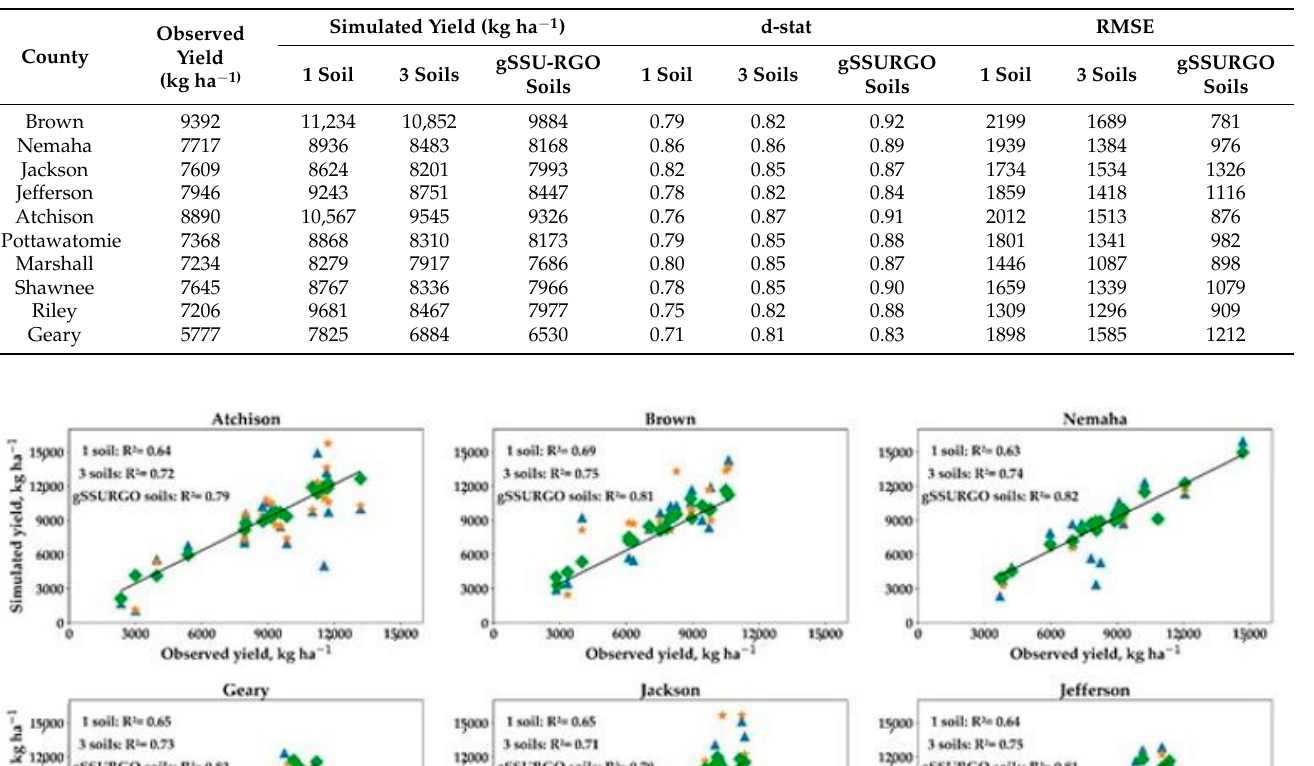
Table 3. Average observed and simulated maize yield with d-stat and RMSE for ten counties and various soil types.